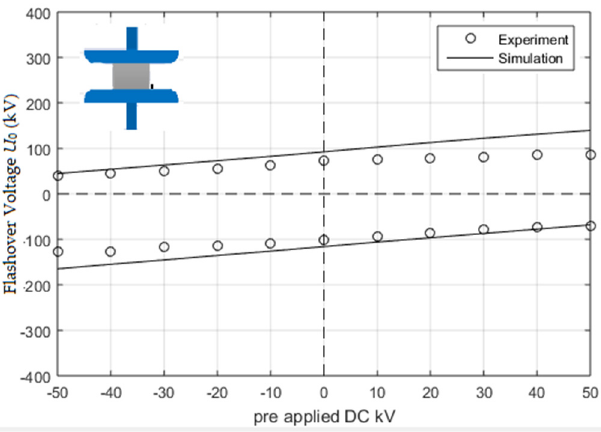
Figure 9. Breakdown characteristics of superimposed flashover voltages with particle (Case 3) contamination size 3 mm, D = 15 mm, P = 0.4 MPa, ε r = 5.93.